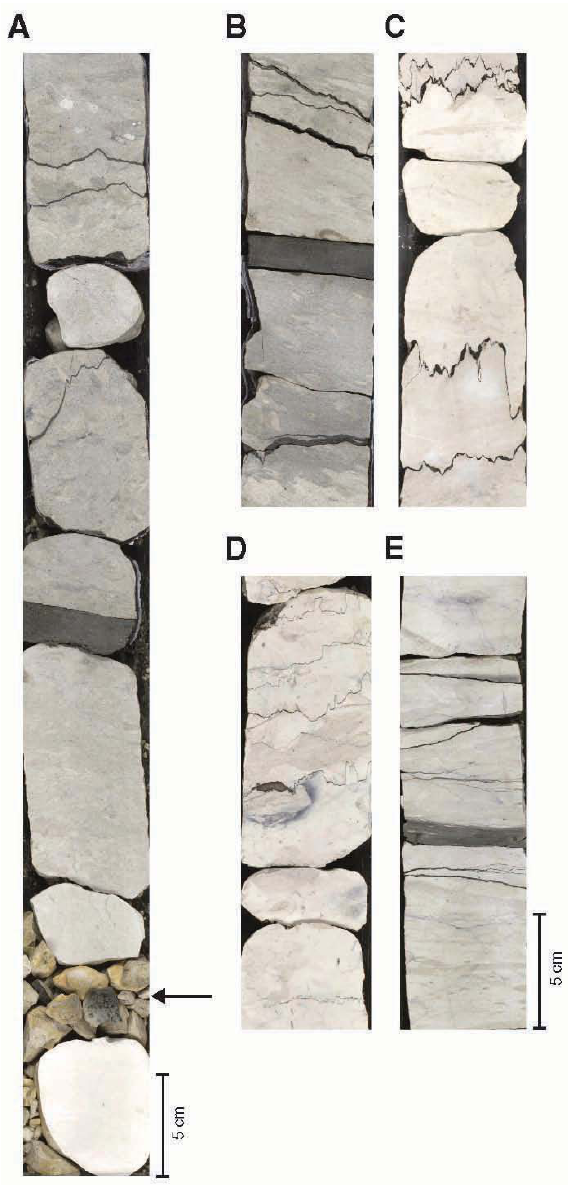
Figure 10. [A] Marshall Paraconformity (arrow) at contact between Units II and III at Site U1352. Only two limestone pieces and some rubble were recovered. However, unconsolidated glauconitic sand may have been present originally, but it was injected into the overlying glauconitic marlstone and limestone to produce the observed layers (see also B), some of which cross cut primary stratigraphy and/or display branching. [B] Glauconitic limestone above the paraconformity. [C] and [D] Stylolitic white limestone (Amuri Limestone equivalent) below the paraconformity. [E] Muddy limestone with layers of marlstone and purple banding below the paraconformity. B–E are at the same vertical scale (from Fulthorpe et al.,